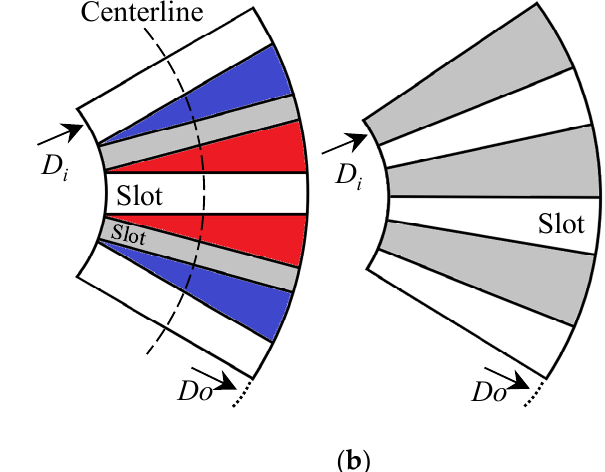
Figure 3. Sketch of the AF-DR FRPM motor with key design parameters: ( a ) cylindrical view; ( b ) top view.